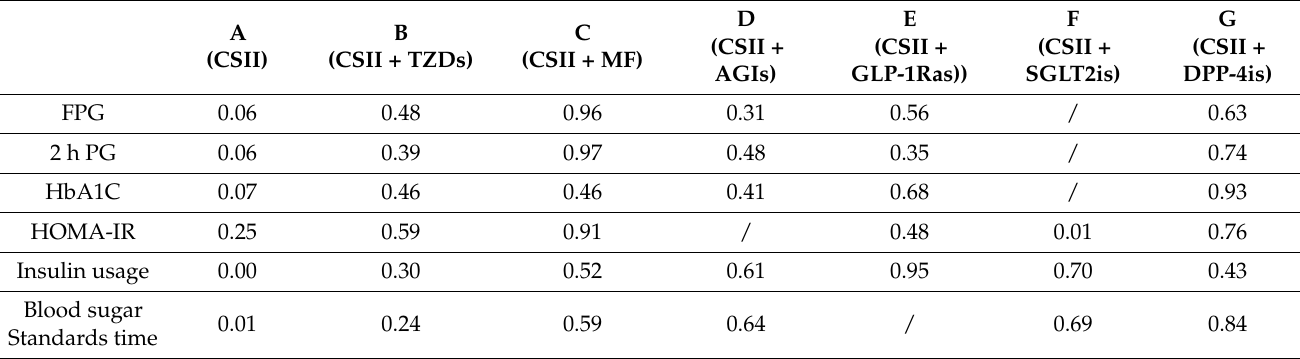
Figure 5. Forest map meta-analysis of different interventions and outcome indicators. Treatments of the various groups: A: “CSII”, B: “CSII+TZDs”, C: “CSII+Metformin/MF”, D: “CSII + AGIs”, E: “CSII + GLP-1Ras”, F: ”CSII + SGLT2is”, and G: “CSII + DPP-4is”. Table 1. SUCRA values of different interventions and